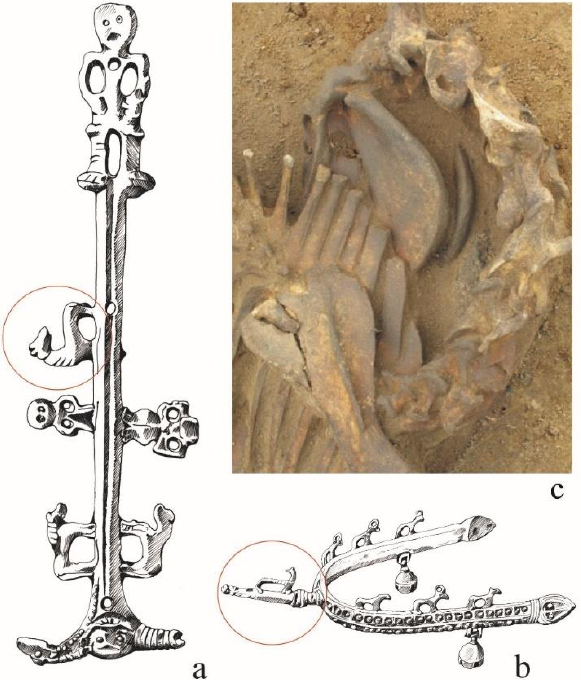
Figure 7. Cases of an unnatural position of the horse’s neck— discussed in the text: a) the Oldenburg knife scabbard ferrule according to Kaczmarek [116] ; b) Spur from Ciepłe , according to Gardeła et knife scabbard ferrule according to Kaczmarek [116]; ( b ) Spur from Ciepłe, according to Gardeła al. [111]; c) horse burial from Pień , according to Makowiecki and Janeczek [96] (Figure prepared by et al. [111]; ( c ) horse burial from Pie´n, according to Makowiecki and Janeczek [96] (Figure prepared J. Sawicka and P. Szczepanik). by J. Sawicka and P.